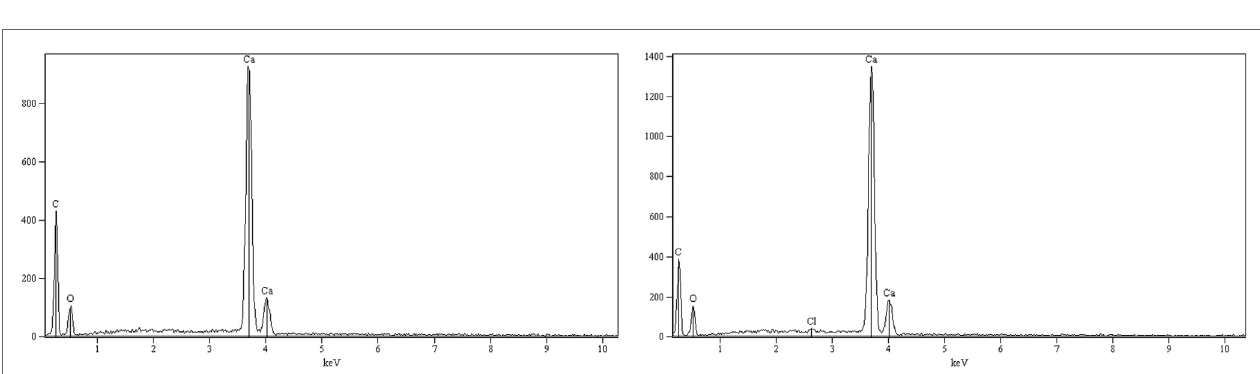
FigUre 11 | seM images of solids separated by pressure filtration from the calcite slurry (test number 5, left) and from the aragonite slurry (test number 15, right)